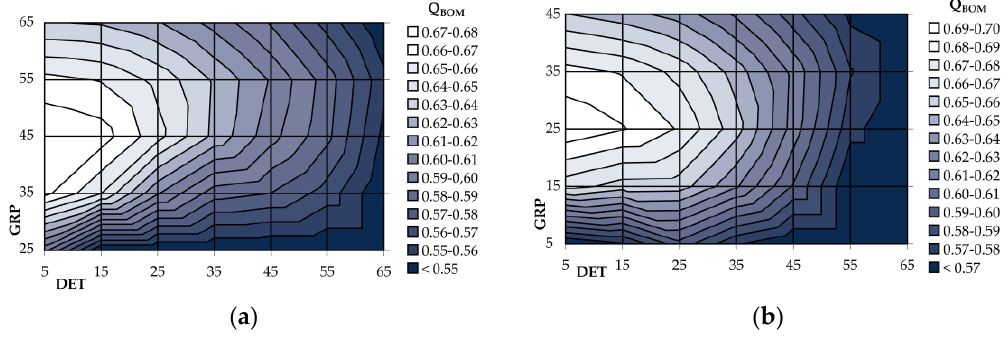
Figure 5. Surface chart of Q BOM values at different parameter combinations of variant DBA-BR ( a ); and variant DBA-BRPPU ( b ).